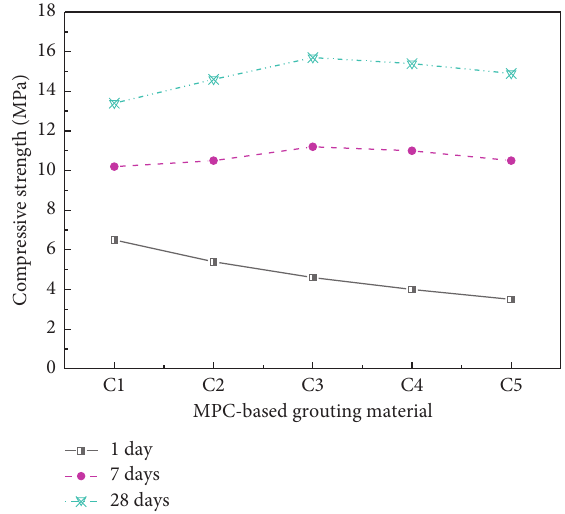
Figure 6: The compressive strength of the hardened sample with different additions of GGBS.